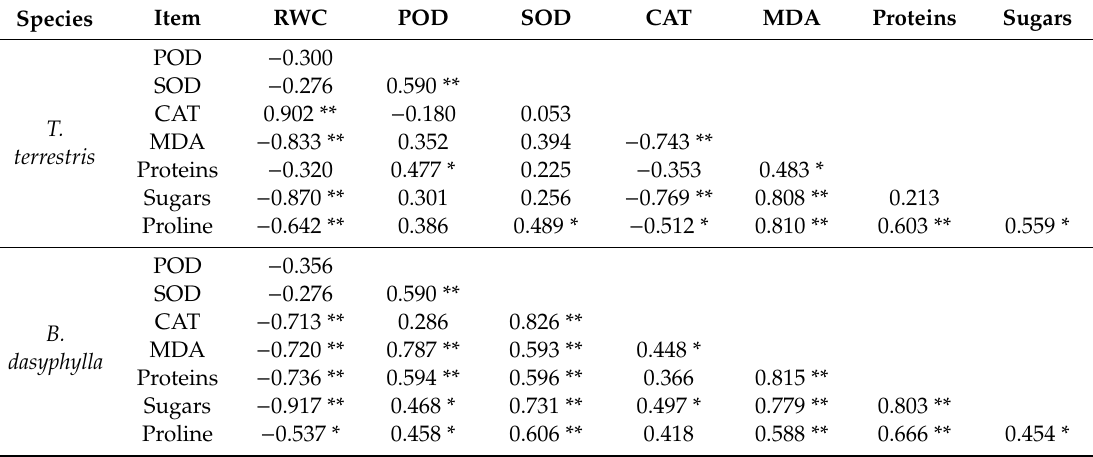
Table 2. Pearson correlation matrix of physiological characteristics of T. terrestris and B. dasyphylla under precipitation